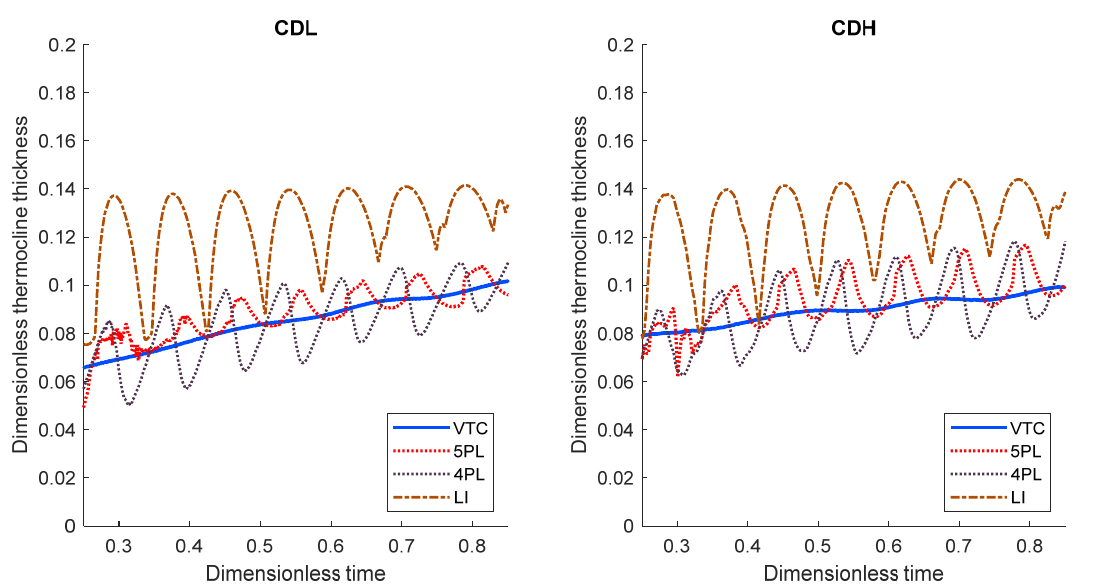
Figure 1. Dimensionless thermocline thickness evolution determined by Virtual TC (VTC), five parameter logistic function (5PL), four-parameter logistic function (4PL) and linear interpolation (LI) during the thermal charge process through the CD inlet at low flow rate (CDL, left side) and high flow rate (CDH, right side).